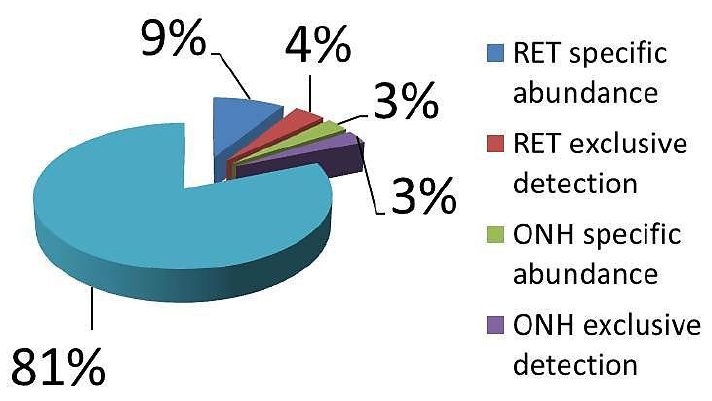
Figure 2. ONH / RET proteomic tissue distribution inferred from BULCMS analysis. Approximately 19% of recovered proteins display characteristic tissue abundances encompassing tissue-exclusive or abundance-related recovery.